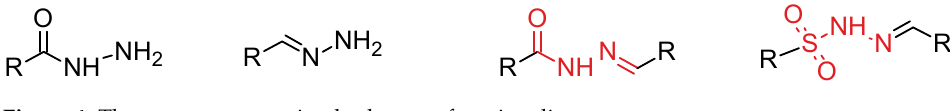
Figure 4. The structures carrying hydrazone functionality.